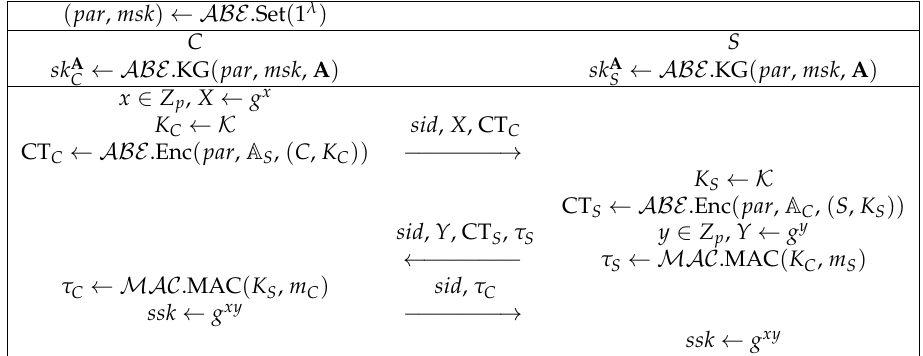
Figure 5. The private and mutual authentication protocol ABEDH, where m C = ( 0, sid , X , Y , C , S ) , m S = ( 1, sid , X , Y , C , S ) , and the elements C , S can be omitted from the protocol. For simplicity, all the related verification and decryption algorithms in the protocol are